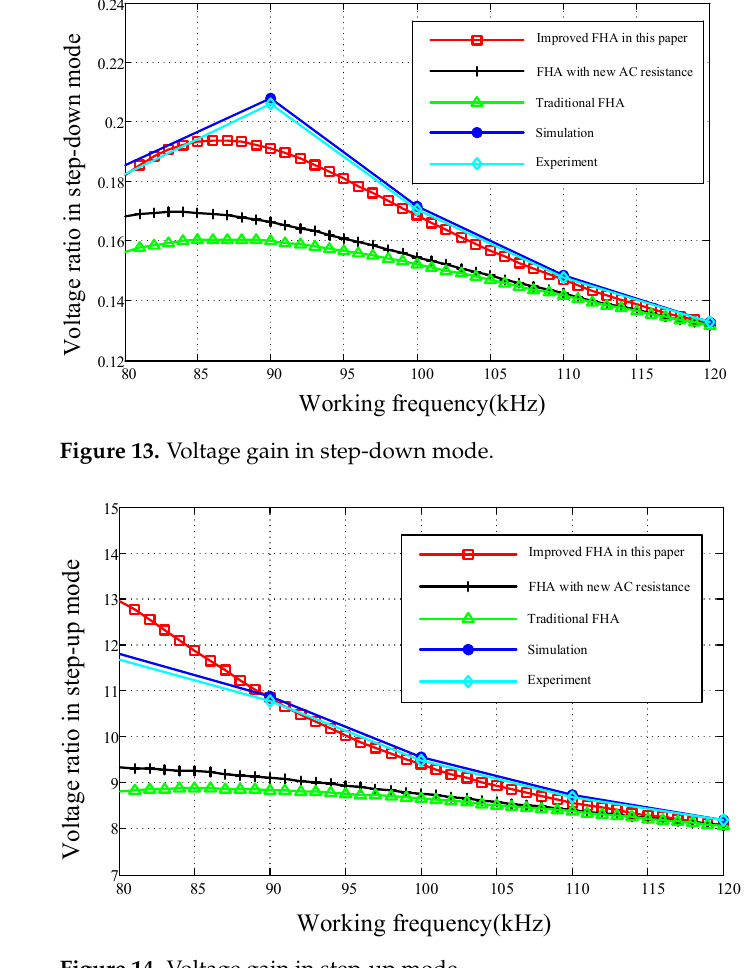
Figure 14. Voltage gain in step-up mode.